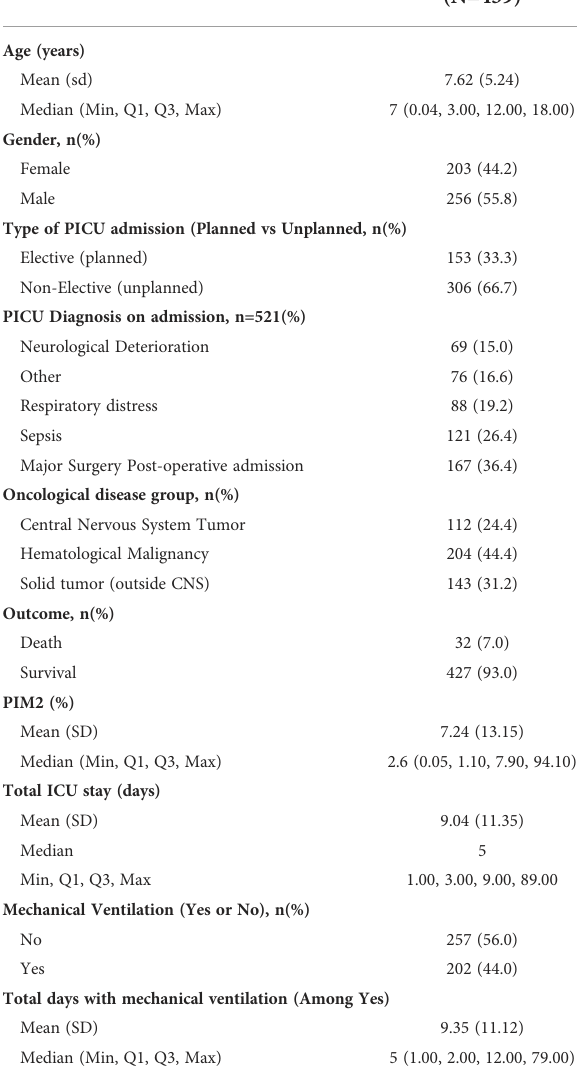
TABLE 1 Summary of Patient